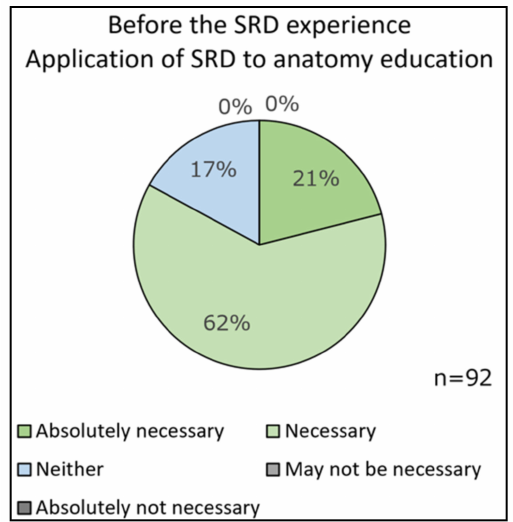
Figure 12. Necessity of the application.